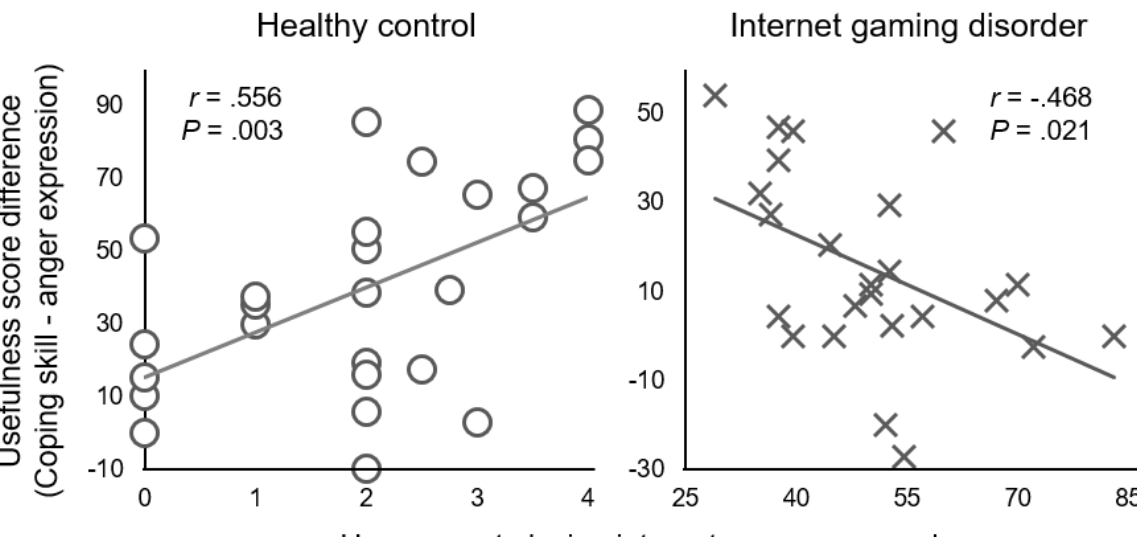
Figure 5. Correlations of mean gaming hours per week with a difference in the usefulness score of